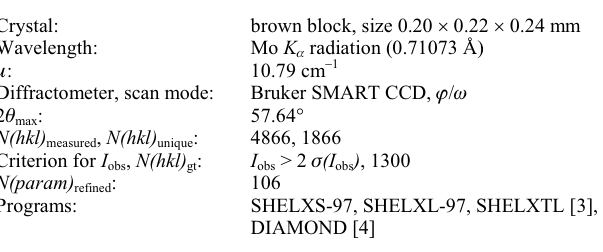
two-dimensional layers are connected via intermolecular O–H ,,, O hydrogen bonding interactions, resulting in a three- dimensional framework.